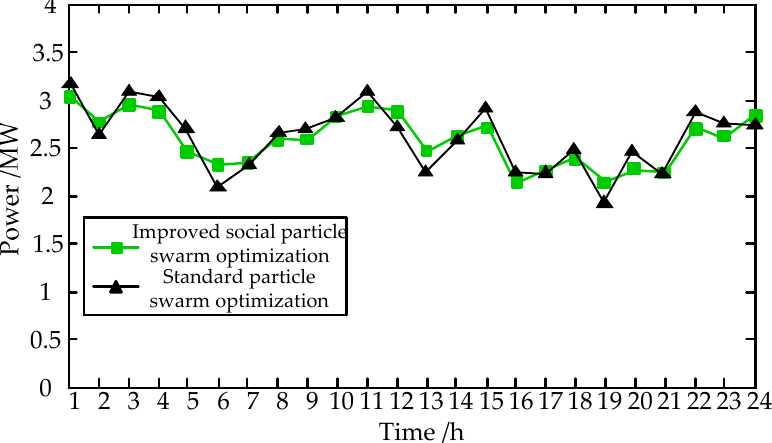
Figure 14. The comparison of the joint output curves between the two strategies on typical day C.